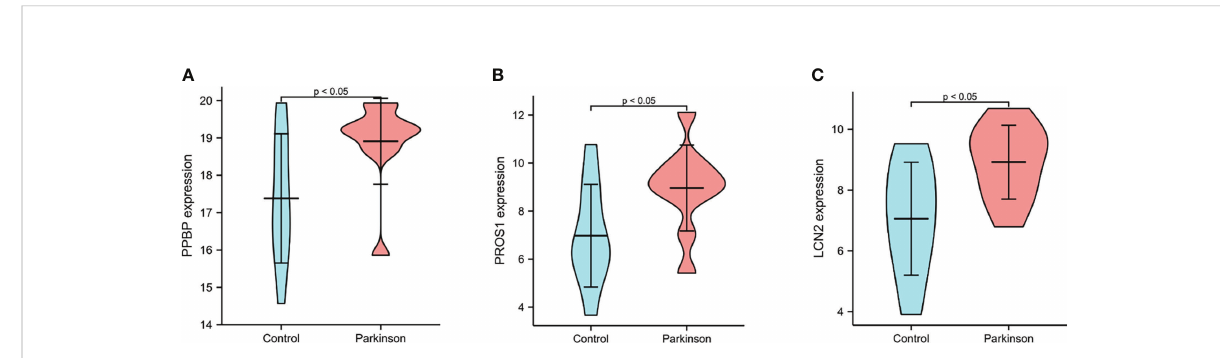
FIGURE 7 The expression levels of PPBP, PROS1 and LCN2 from PD patients and healthy controls in GSE100054. (A – C) The expression of PPBP, PROS1 and LCN2 in GSE100054. p < 0.05 was considered to be statistically